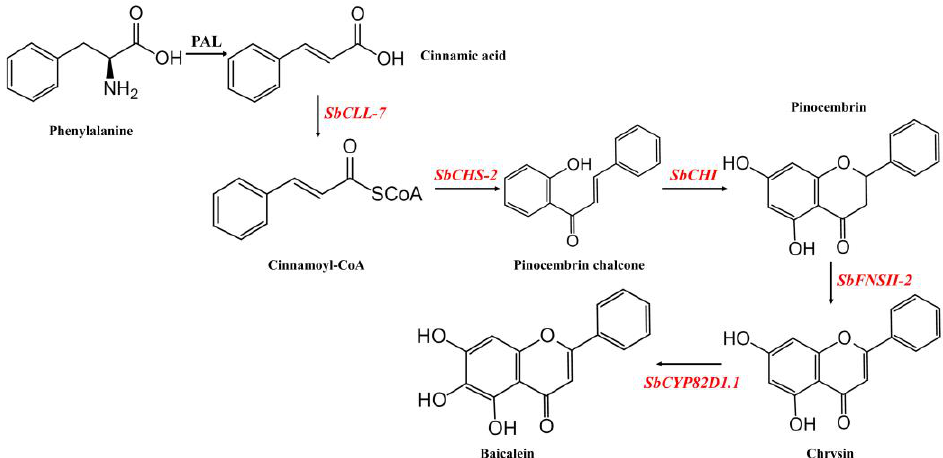
Figure 1. Map of the engineered baicalein biosynthesis pathway in Lycopersicon esculentum . Baicalein biosynthesis genes that were transformed into tomatoes in this study are marked in red. The five genes involved in the baicalein biosynthetic pathway are SbCLL-7 , cinnamoyl-coenzyme A (CoA) ligase; SbCHS-2 , chalcone synthase; SbCHI , chalcone isomerase; SbFNSII-2 , flavone synthase II and SbCYP82D1.1 , flavonoid 6-hydroxylases, respectively.